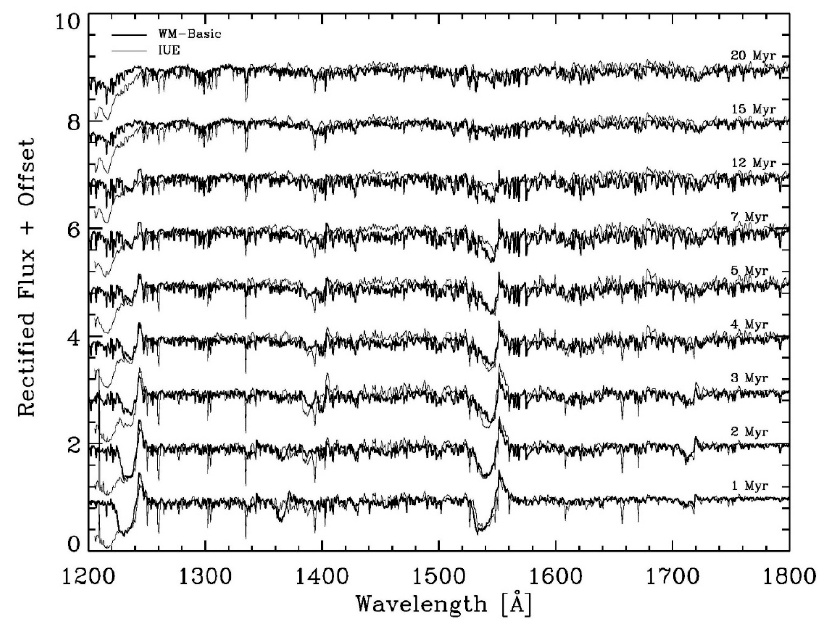
Figure 13. Comparison of the simulated spectra of a single stellar population with a solar chemical composition (thick lines) and an observational IUE library of Galactic stars (thin). The age steps from 1 to 20 Myr are labeled on the right. From [59].